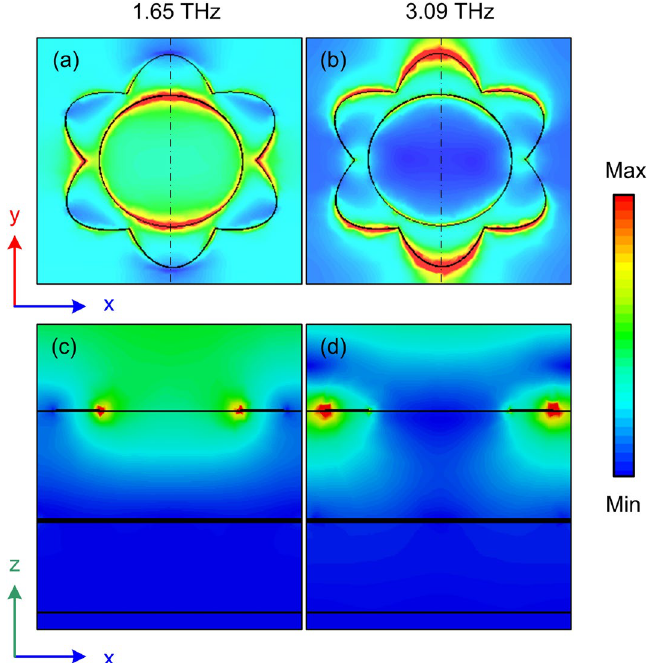
Figure 10. Electric field distribution in a unit cell for y -polarized incident waves at the resonant frequencies in ( a ) XY plane (top-view) and ( b ) XZ plane (determined at the position by the black dash-dotted lines in Fig. 10.